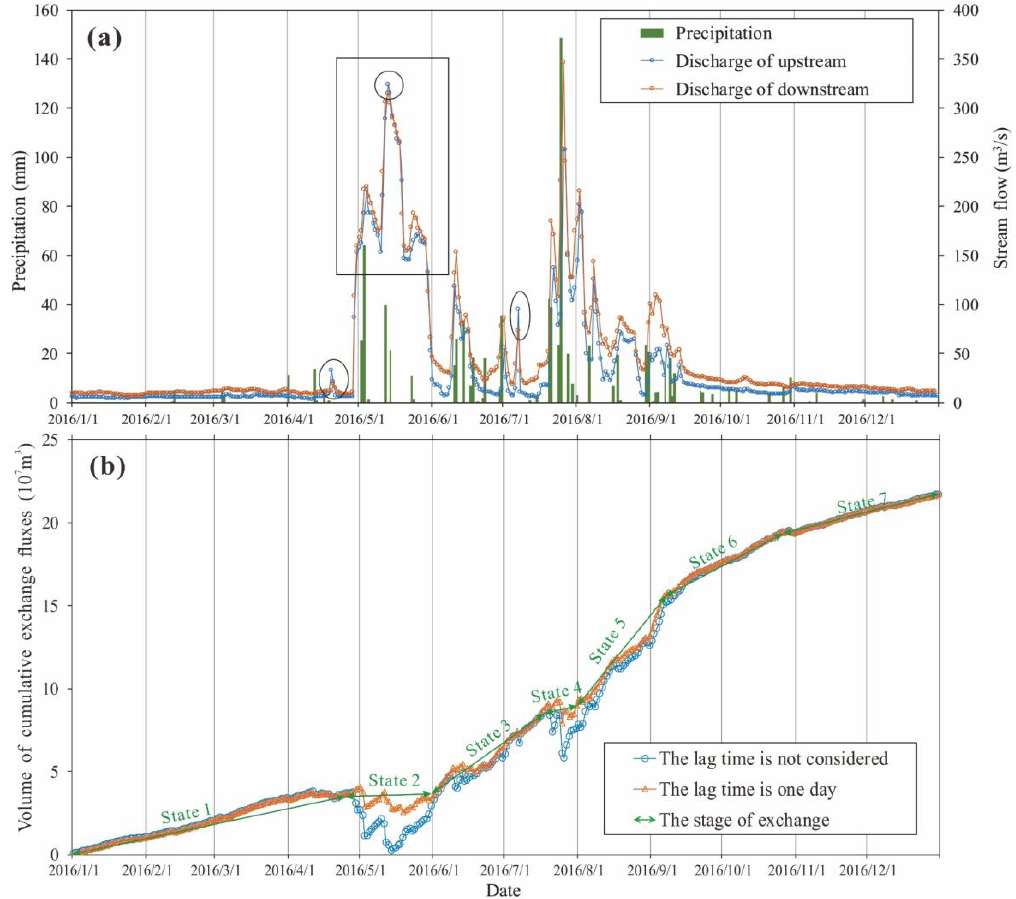
Figure 3. ( a ) Precipitation and the flow of upstream and downstream of study reach and ( b ) results of cumulative exchange fluxes.